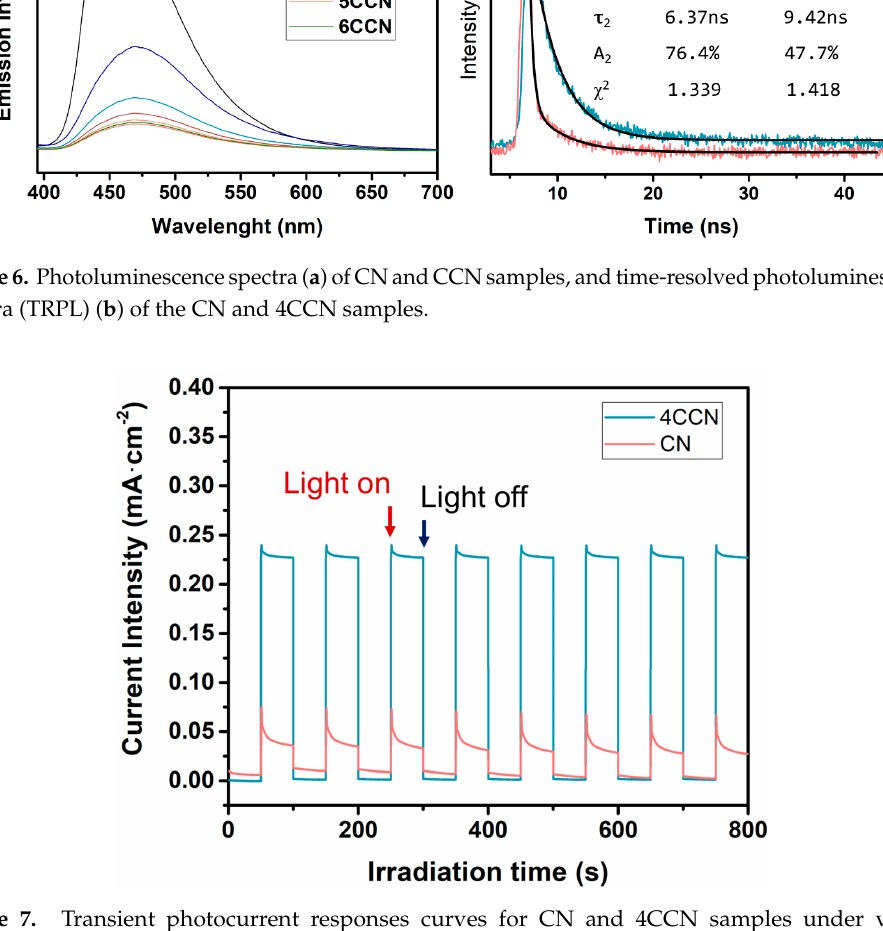
Figure 7. Transient photocurrent responses curves for CN and 4CCN samples under visible light irradiation.